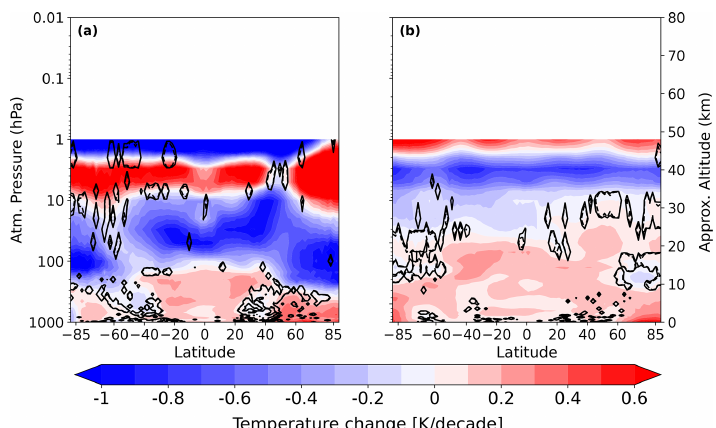
Figure A2. Profiles of temperature trends (K per decade) obtained from the ERA-5 reanalysis dataset. (a) Ozone depletion phase (1985– 1997); (b) ozone recovery phase (1998–2018). The dashed line indicates the region with significance at the 90% level for positive or negative changes, the solid line is the same at the 95%